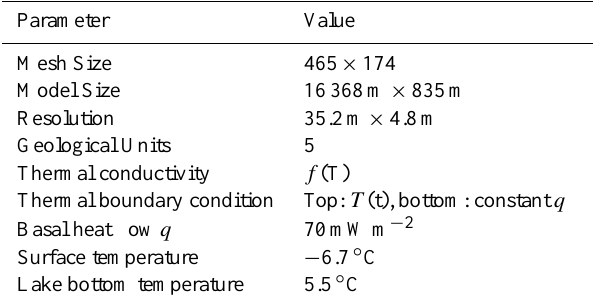
Table 3. Properties of the 2-D model. In case of the transient mod- eling, the temperature at the upper boundary is time dependent as shown in Figure